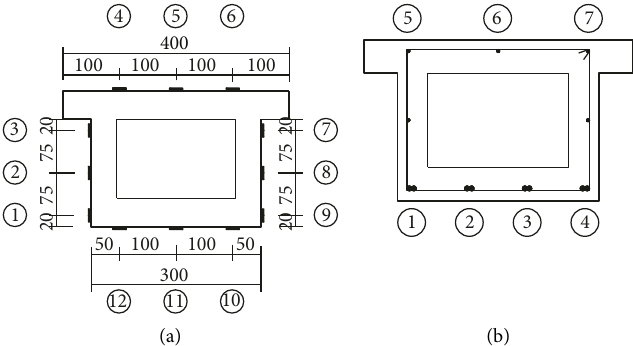
Figure 2: Arrangement of strain gauge of test beam (unit: mm). (a) Arrangement of concrete strain gauges. (b) Arrangement of rein- forcement strain gauge.